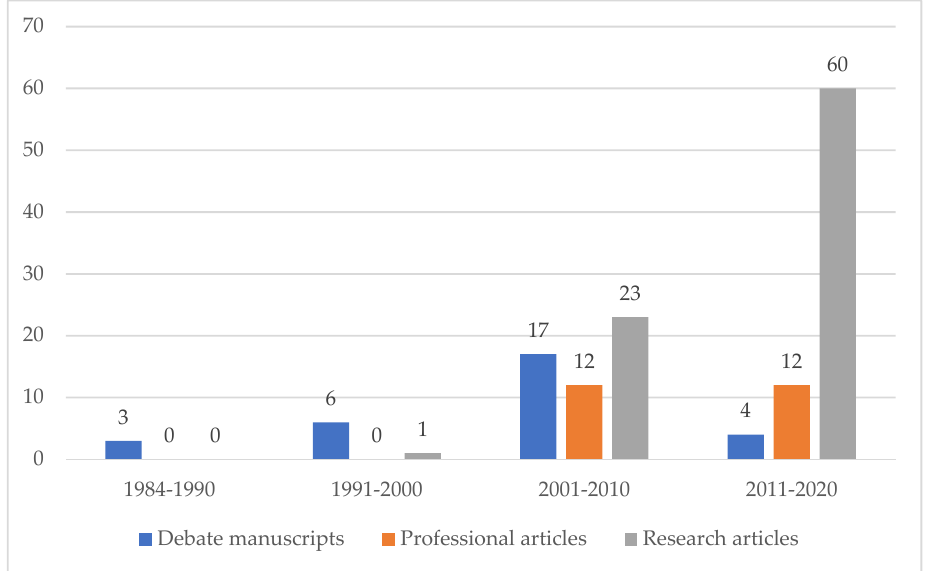
Figure 2. Overview of publications in Scandinavian healthcare journals using the concept of ‘existential’. The figure illustrates the number of debate manuscripts (blue), professional articles (red) and research articles (grey).